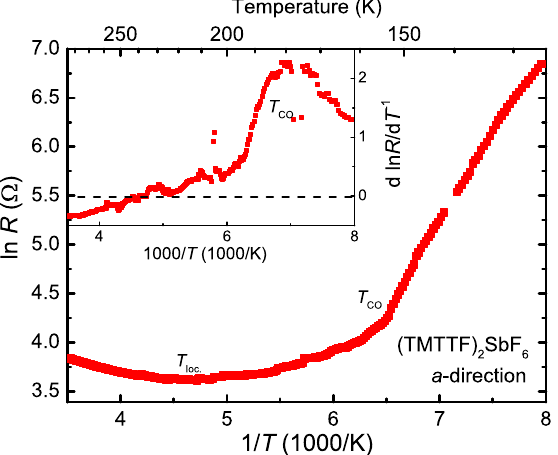
Figure 6. Logarithm of the resistance of (TMTTF) 2 SbF 6 as a function of the inverse temperature 1/ T . At about T = 215 K a minimum appears, marking the transition to the localized state related to the opening of a Mott gap. The resistance increased slightly and at T CO = 157 K a kink is observed in the curve due to the charge order transition. Inset: derivative of the logarithm of the resistance vs. 1/ T . The charge localization leads to a change of the sign from negative (metallic) to positive (insulating). Also the slope changes at T CO leading to a rather flat curve at low